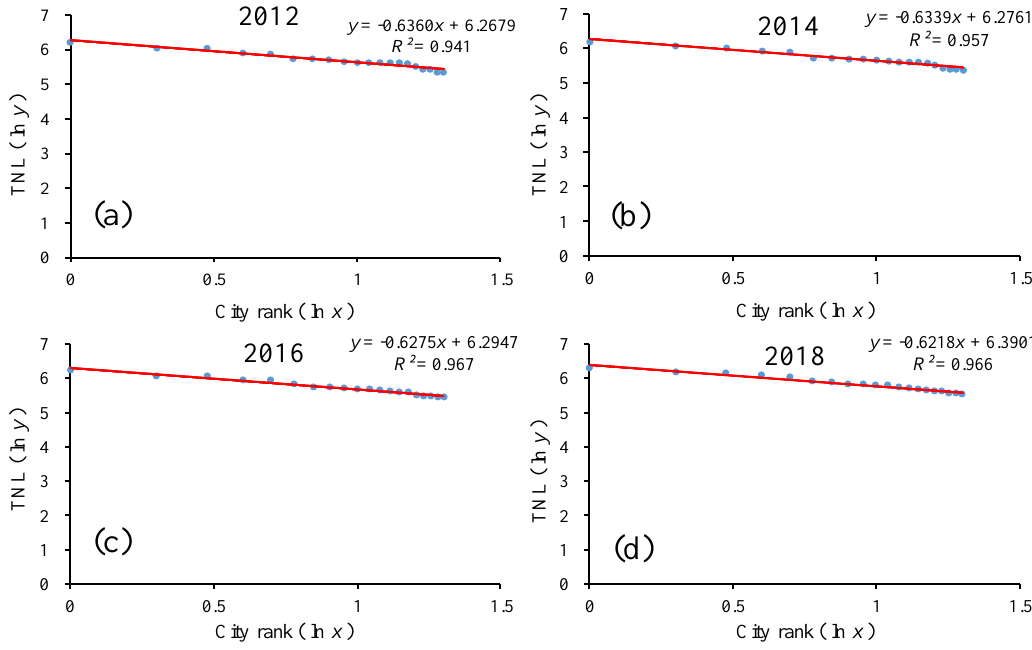
Figure 8. The ln-ln plot of the rank–size of the urban development for the top 20 provinces. Line regression of ( a ) TNL and ranking of the top 20 provinces in 2012; ( b ) TNL and ranking of the top 20 provinces in 2014; ( c ) TNL and ranking of the top 20 provinces in 2016; ( d ) TNL and ranking of the 20 provinces in 2018.